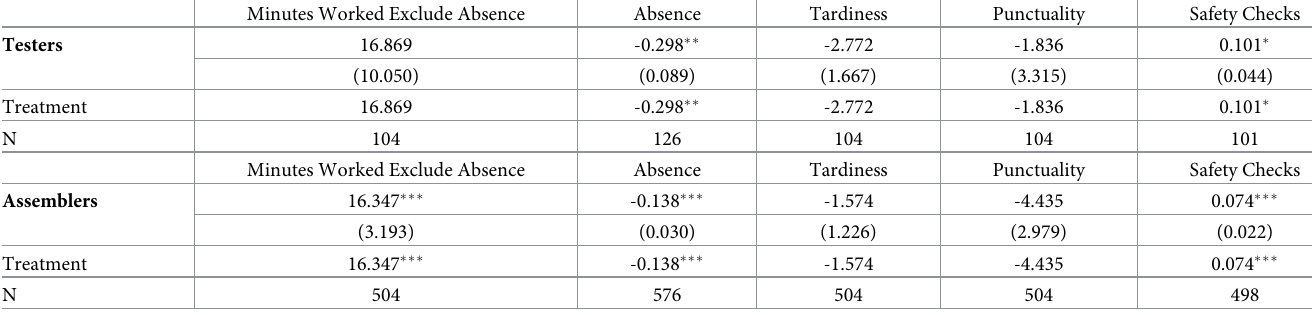
Table 4. Fixed effects estimates separately by worker type. (ex post +9